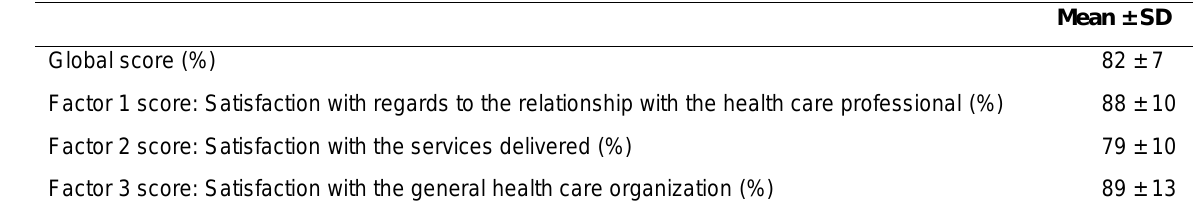
UPPER LIMB FUNCTION On the F-DASH questionnaire, a difference of 42.1± 11.4 (p < 0.001) in upper limb function was observed. This is much greater than the minimal clinical difference (change over 15/100) (Beaton, Davis, Hudak, & McConnell, 2001). Table 2. Patients’ Satisfaction Toward Received